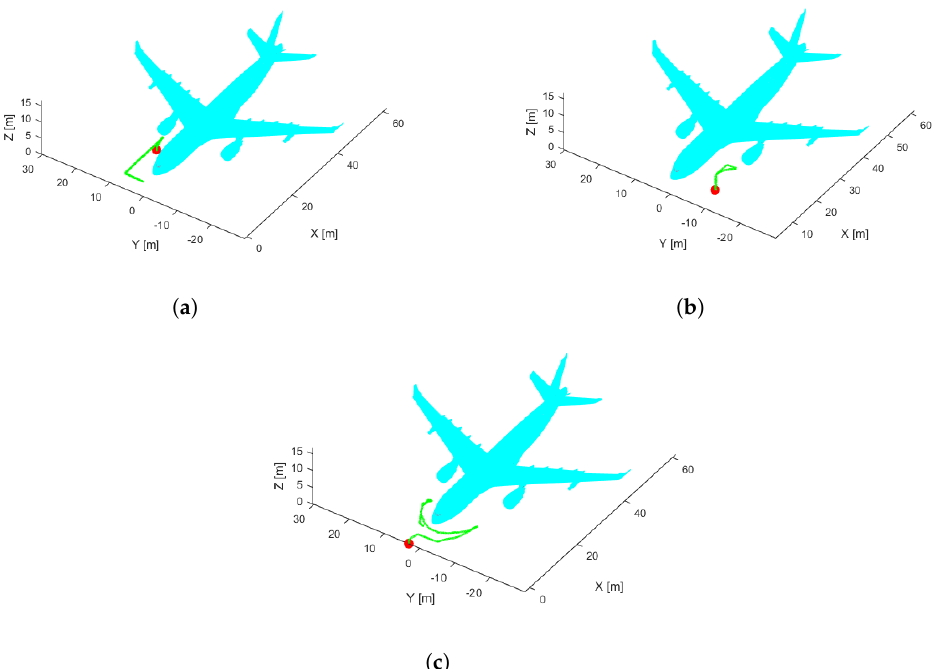
Figure 16. Proposed trajectories for real flights. Take-off and landing point (red circle). ( a ) Path 1.